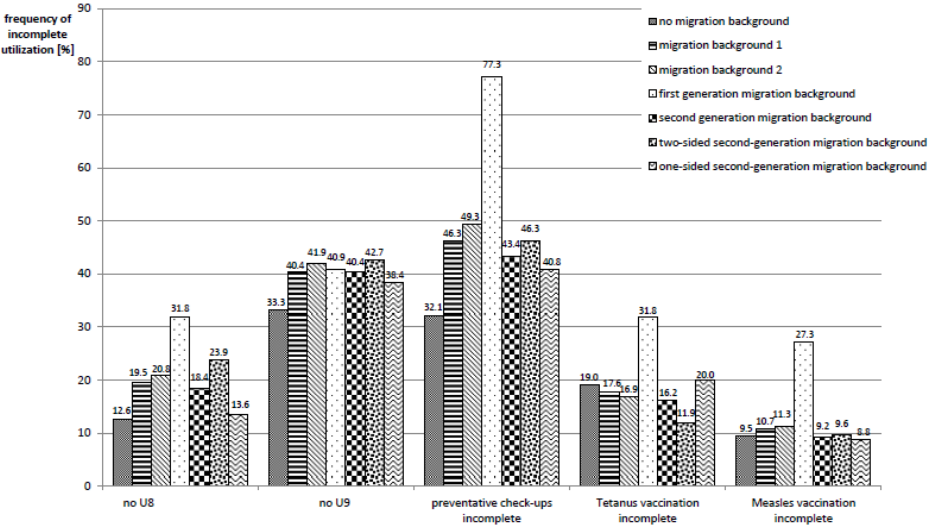
Figure 2. Frequencies of incomplete utilization of preventative health services, stratified according to migration status.